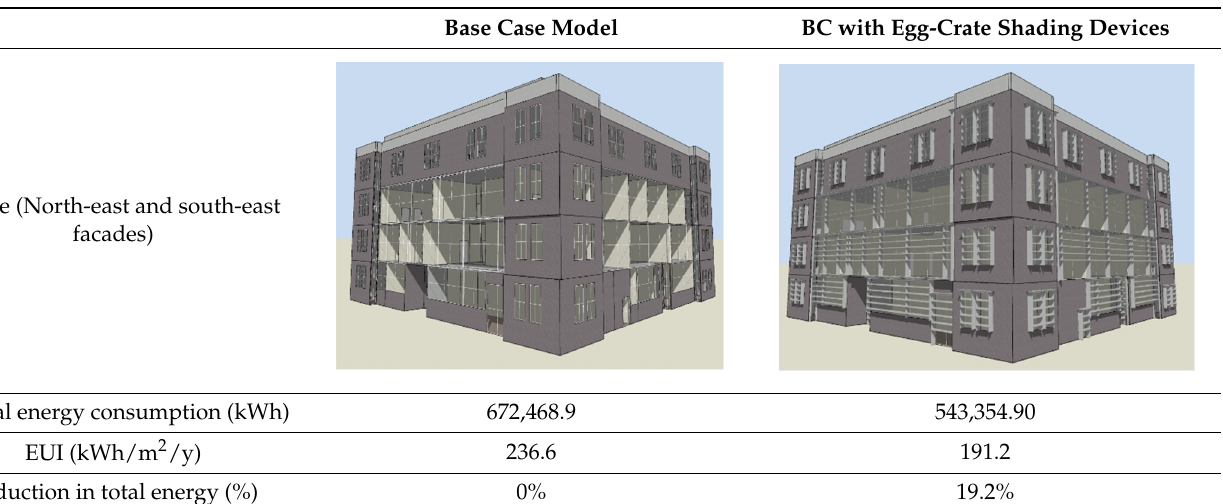
Table 7. Difference in the shape of the exterior building without and with shading devices.